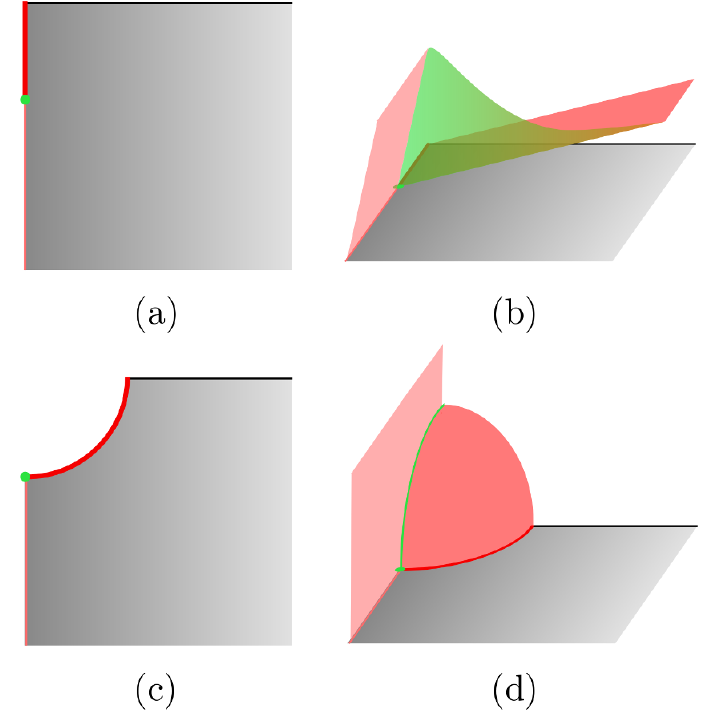
Figure 8 . BCFT models for single-sided black